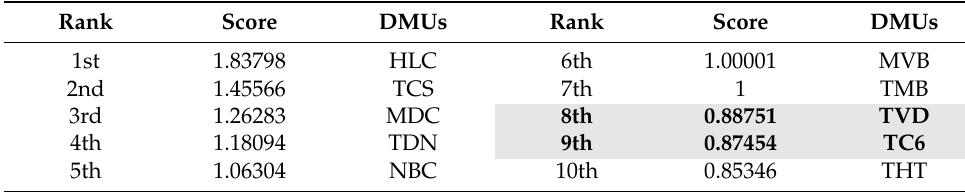
Table 7. Performance ranking of DMUs in 2020.